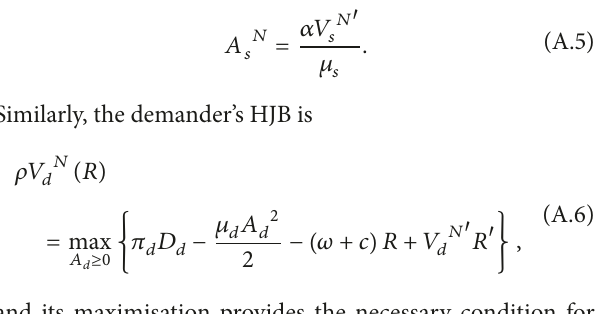
Figure 11: Impact of 𝜔 on the feasible region of the cost-sharing